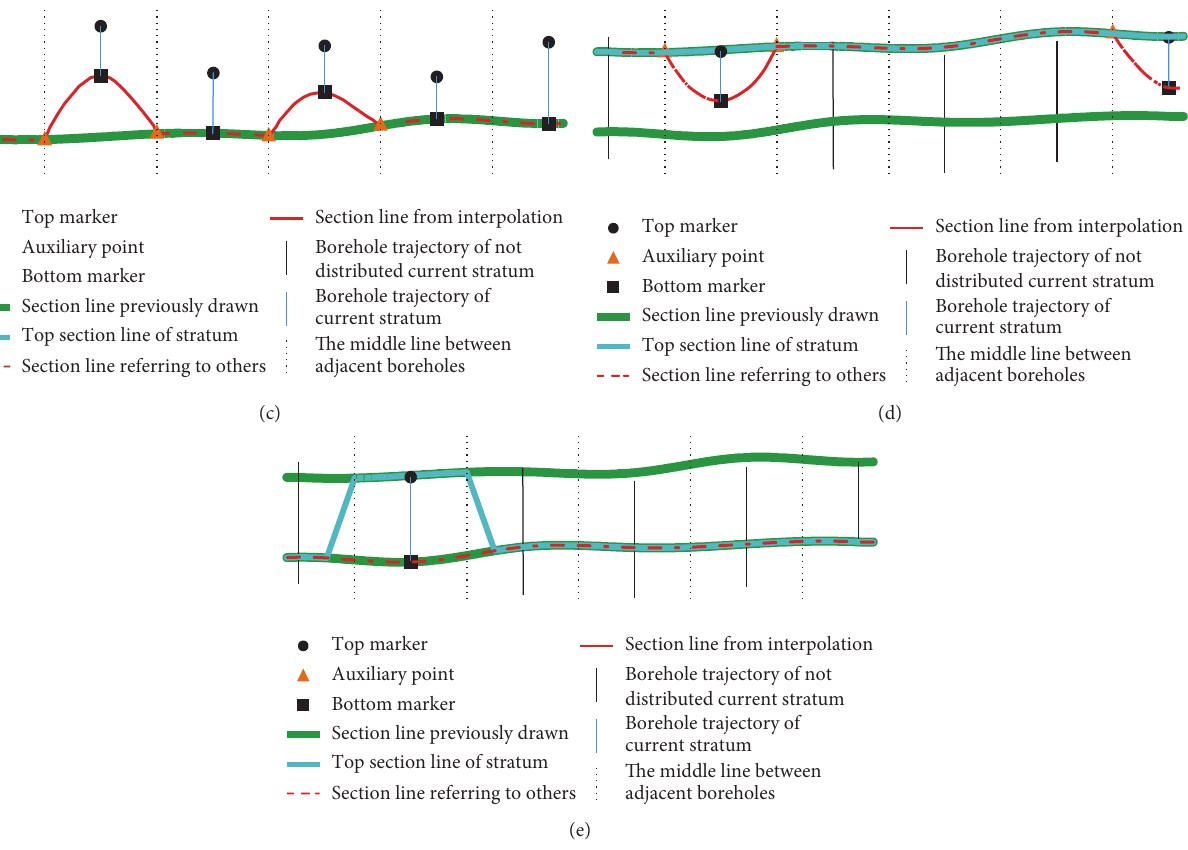
Figure 7: Diagram of automatically plotting the bottom boundary of the current layer: (a) section line of direct interpolation, (b) section line from the referred section line and interpolation with the constraint of auxiliary border points, (c) section line from the referred section line and interpolation with the constraint of auxiliary reference top points, and (d) section line from the referred section line and interpolation with the constraint of auxiliary reference base points. (e) section line from the referred section line